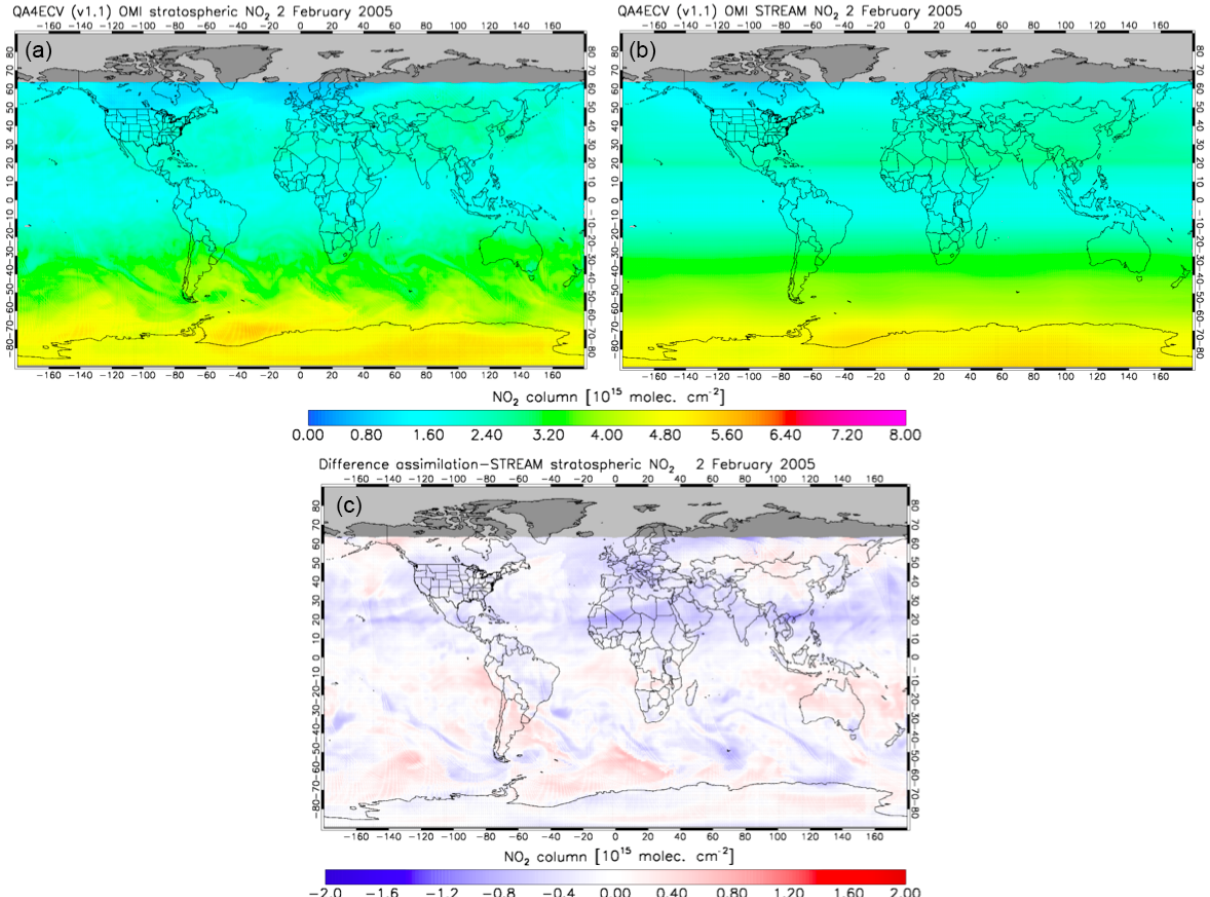
Figure 5. Stratospheric NO 2 columns from OMI on 2 February 2005, estimated with the data assimilation method (a) and with the STREAM method (b) . Panel (c) shows the differences between the stratospheric NO 2